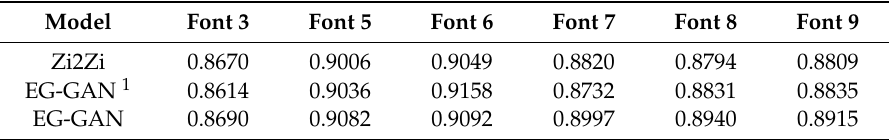
Table 4. Comparison of SSIM metrics for each single font.